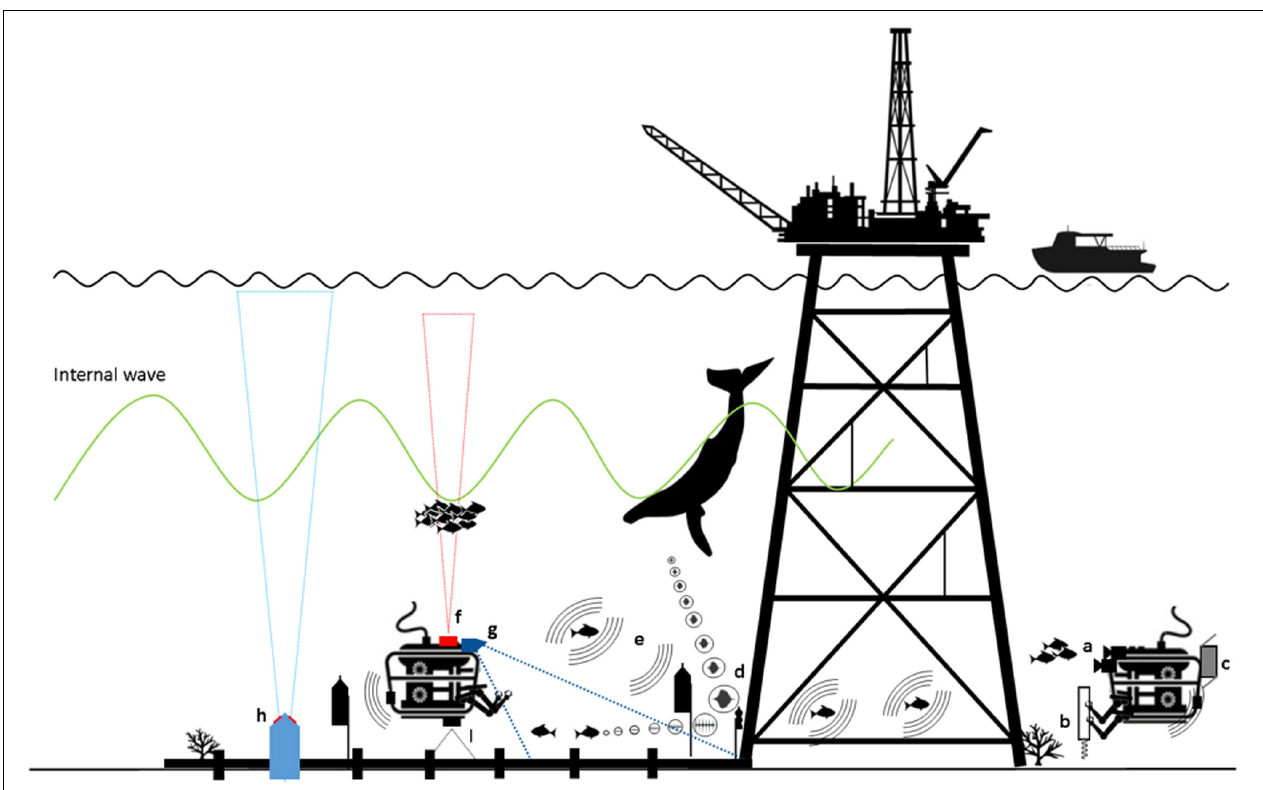
FIGURE 2 | Industrial remotely operated vehicles (ROVs) can be enhanced to collect scientific information through the addition of (a) high definition video and still photograph cameras; (b) sediment core samplers; (c) Niskin bottle water sampler; (d) passive acoustic monitoring; (e) acoustic telemetry tags and receivers; (f) echosounder; (g) forward-looking multibeam; (h) Acoustic Doppler current profilers (ADCP); (i) mapping multibeam. Diagram not to